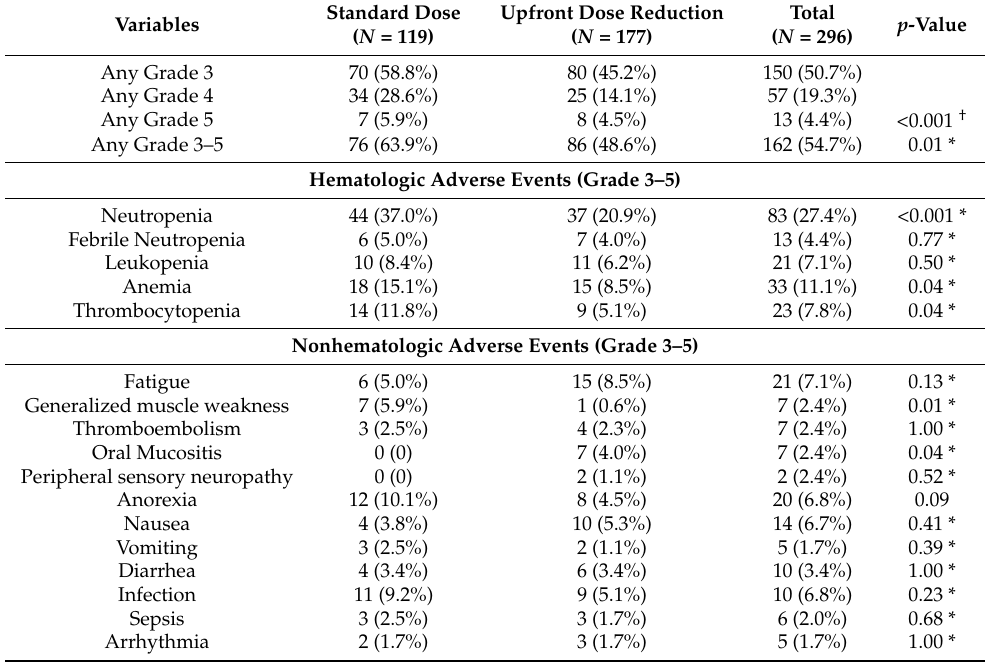
Table 4. Grade 3–5 adverse